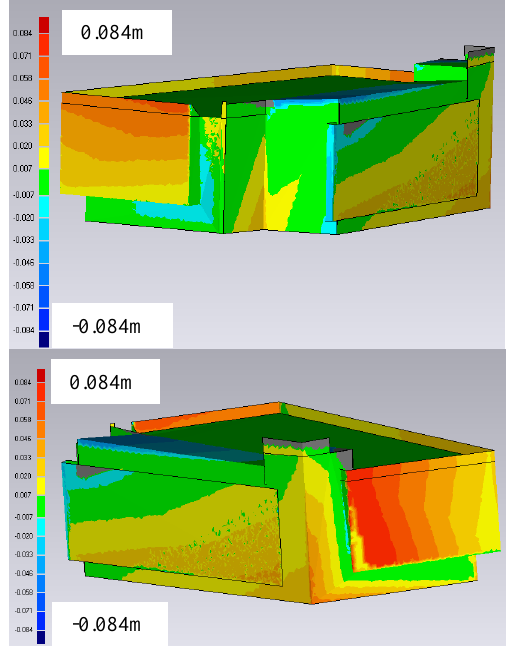
Figure 15. 3D difference map of the front (top) and the back (bottom) facade between the Canon and the iPad 3D model Both the iPhone and the iPad have produced good quality 3D building models when compared with the Canon model. The iPhone with its larger image format and higher resolution enables better measurements to be made than on the iPad images. Further investigations into the systematic patterns and a wider number of applications will be